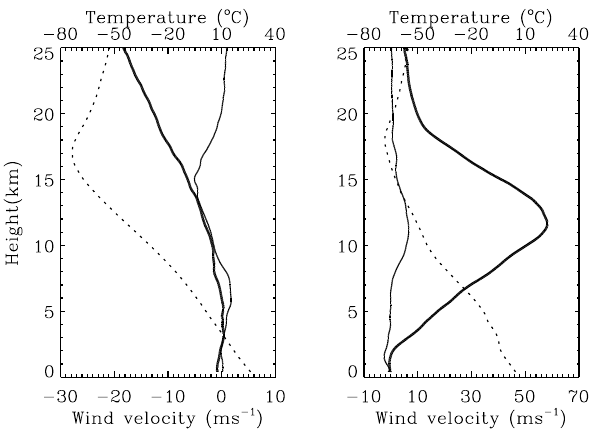
Fig. 3. The background zonal wind (thick solid), meridional wind (thin solid) and temperature (dotted) in August 2006 (left) and Jan- uary 2007 (right).